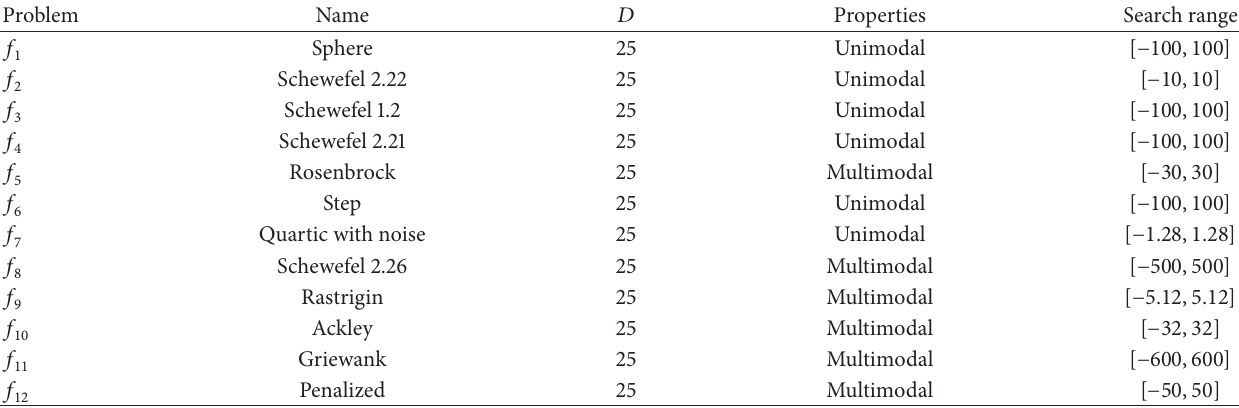
Table 1: The 12 classical benchmark optimization problems